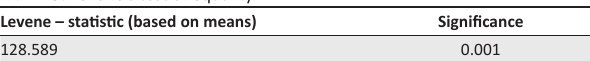
TABLE 9: Levene’s test of equality. Levene – statistic (based on means)